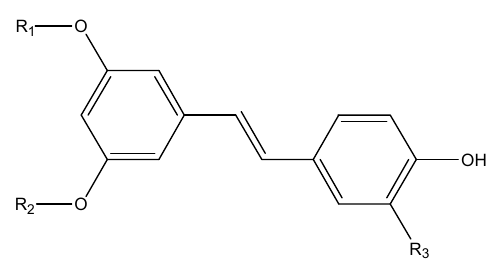
Figure 10. The chemical structures of resveratrol (R 1 = R 2 = R 3 = H), pterostilbene (R 1 = R 2 = CH3, R 3 = OH), piceatannol (R 1 = R 2 = H, R 3 = OH).